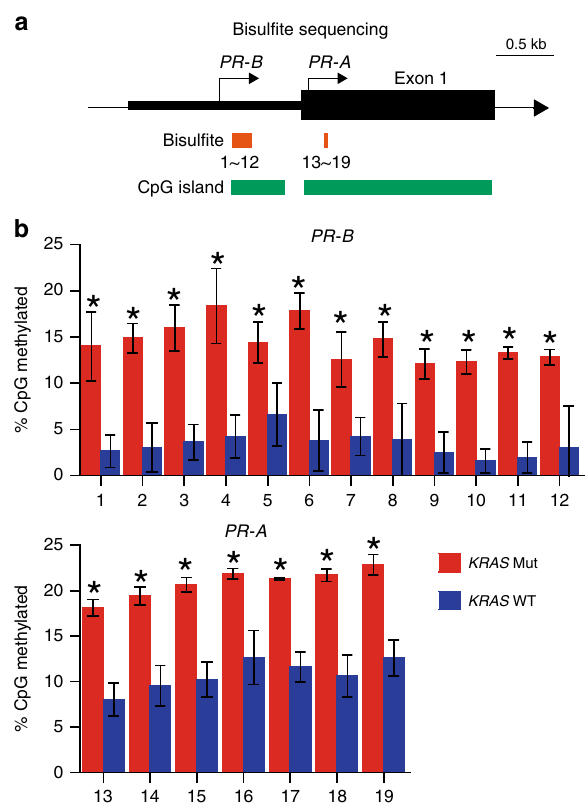
Fig. 8 Mutant KRAS expression is linked to epigenetic silencing of PR . a Schematic diagram of the PR - A/B promoters and exon 1. Transcription start sites (arrows), CpG islands, and regions of bisul fi te sequencing are indicated. b Frequency of methylated CpG in PR - B (top) and PR-A (bottom) as determined by bisul fi te sequencing of DNA from KRAS -WT ( n = 20) and KRAS -mutated ( n = 11) adenomyosis samples. Data are the mean + SD. * p < 0.05 by Welch ’ s t